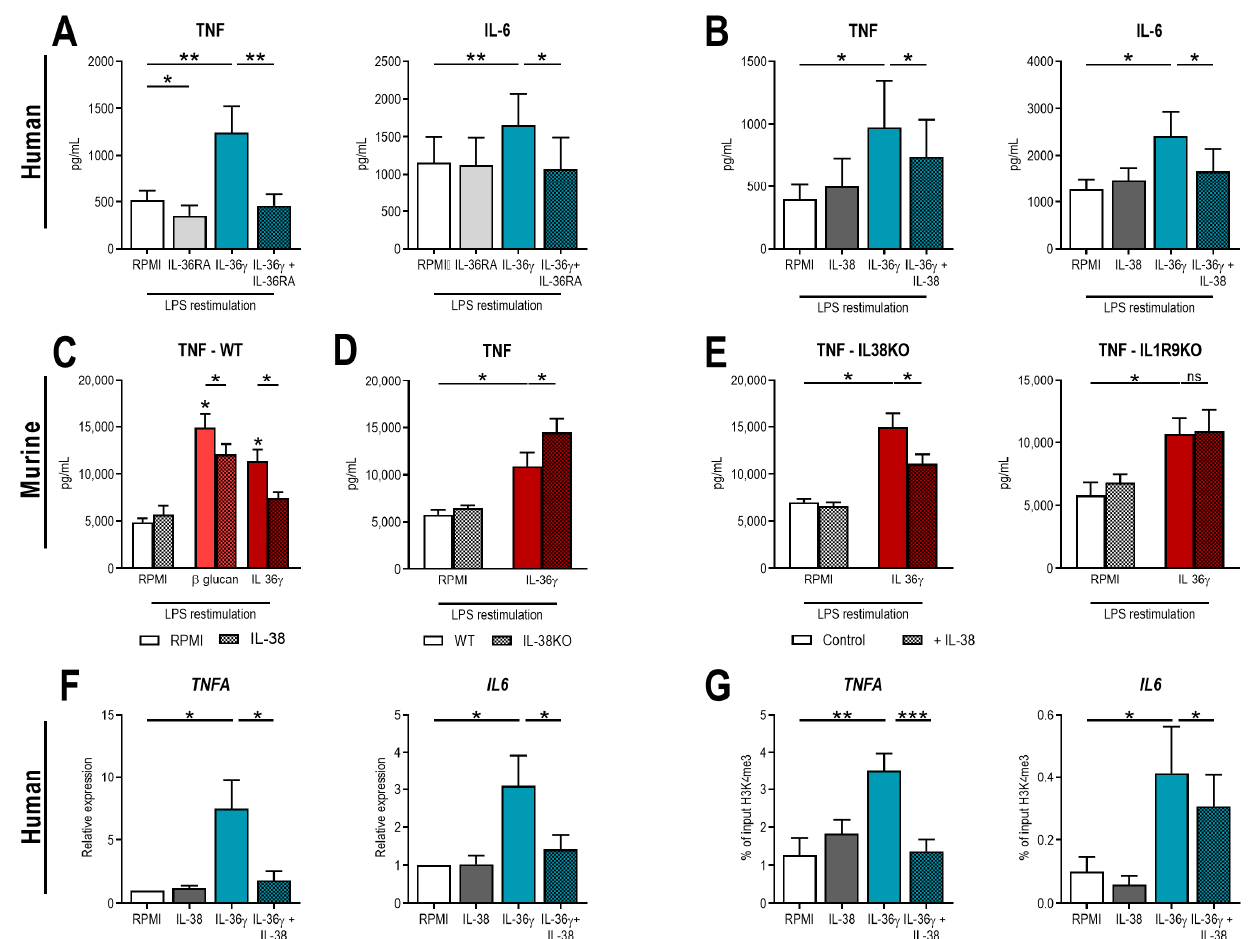
Figure 2. IL-36 γ induces trained immunity. ( A , B ) Human monocytes were incubated for 24 h with 50 ng/mL of IL-36 γ with or without 400 ng/mL IL-36RA ( A ) or 90 ng/mL IL-38 ( B ). After five days of rest in medium, cells were restimulated with 10 ng/mL LPS, and TNF and IL-6 were determined in supernatants. ( C ) Fresh bone marrow of WT mice was stimulated with 2 µ g/mL β -glucan or 50 ng/mL IL-36 µ in the presence or absence of 90 ng/mL IL-38 for 48 h. After four days of rest, cells were restimulated with 10 ng/mL LPS for 24 h. TNF production was determined in supernatants. ( D ) Fresh bone marrow cells of WT and IL-38KO mice were incubated for 24 h with 50 ng/mL IL-36 γ . After four days of rest, cells were restimulated with 10 ng/mL LPS for 24 h. TNF production was determined in supernatants. ( E ) Fresh bone marrow of IL-38KO and IL-1R9KO mice was incubated with 50 ng/mL IL-36 γ in the presence or absence of 90 ng/mL IL-38 for 48 h. After four days of rest, cells were restimulated with 10 ng/mL LPS for 24 h. TNF production was determined in supernatants. ( F ) Human monocytes were incubated for 24 h with 50 ng/mL of IL-36 γ with or without 90 ng/mL IL-38. After five days of rest in medium, cells were restimulated with 10 ng/mL LPS, and expression of TNFA and IL6 was determined after 4 h. ( G ) Human monocytes were incubated for 24 h with 50 ng/mL of IL-36 γ with or without 90 ng/mL IL-38. After five days of rest in medium, cells were fixed, and the percentage of H3K4me3 at the promoters of TNFA and IL6 was determined. (Mean ± SEM, n = 6, Wilcoxon signed-rank test, ns = non-significant, * p < 0.05, ** p < 0.01, *** p < 0.001.)